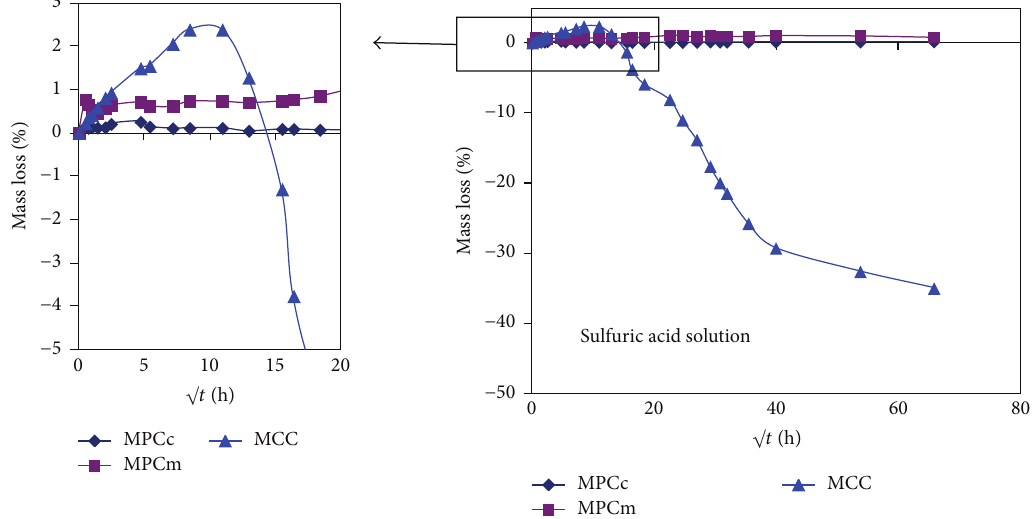
Figure 11: Mass change of microconcretes due to the immersion in sulfuric acid.